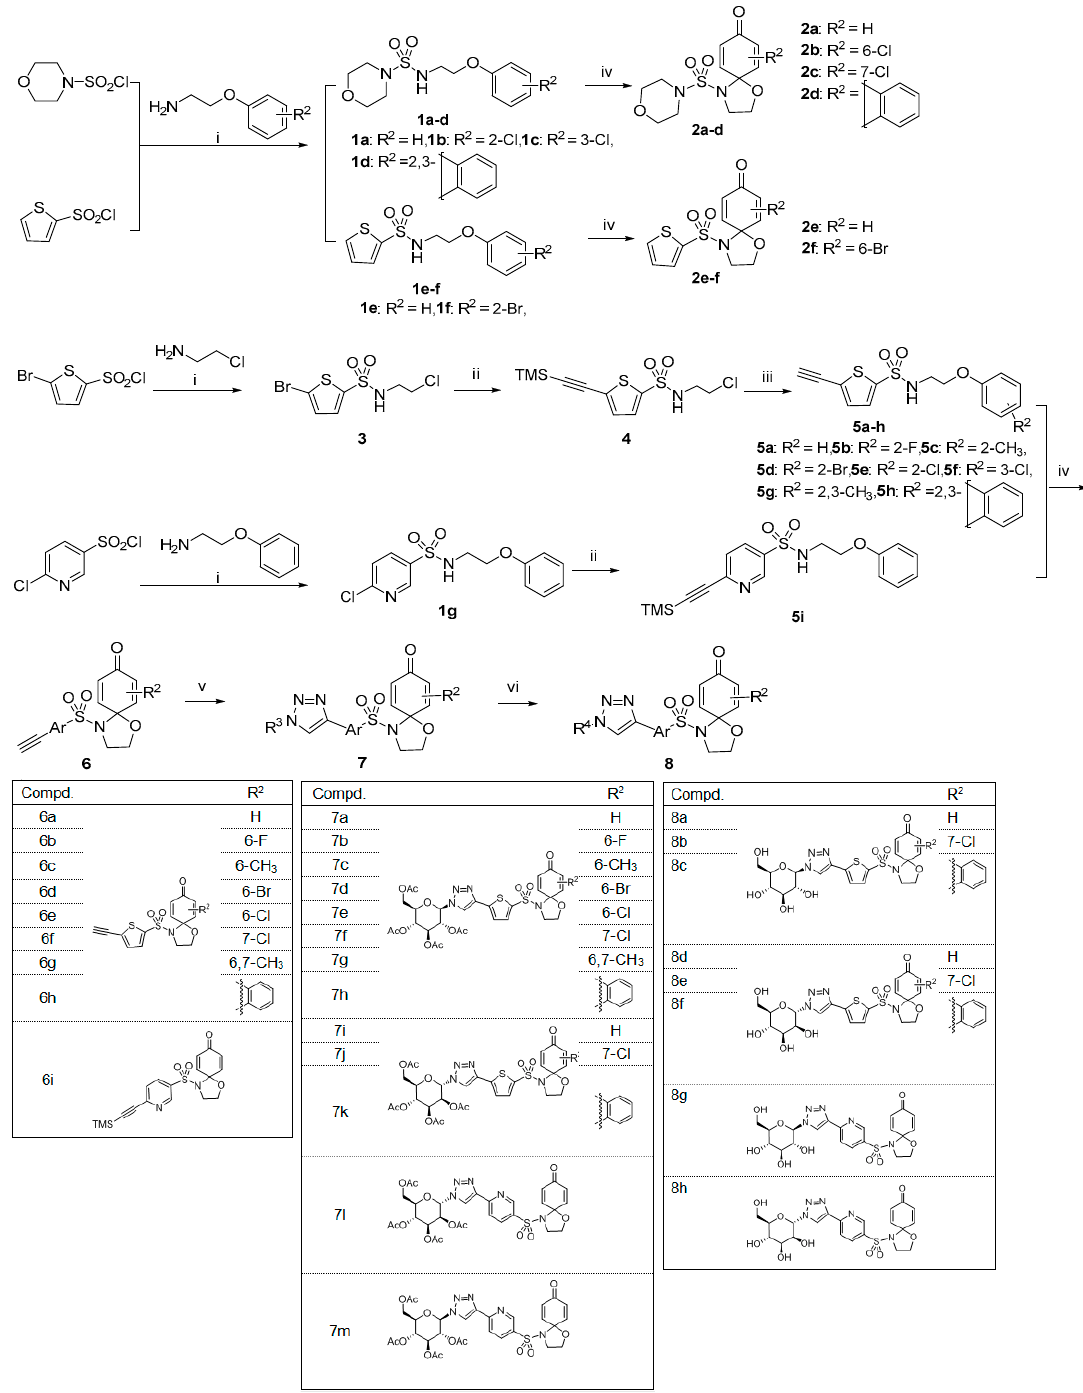
Figure 2. Design of novel sulfonylazaspirodienone derivatives from 4-tosyl-1-oxa-4-azaspire[4.5]deca-6,9-dien-8-one